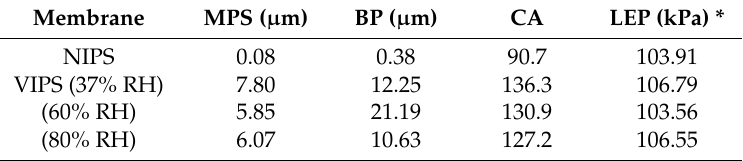
Table 2. Summary of membrane properties prepared using NIPS and vapor-induced phase